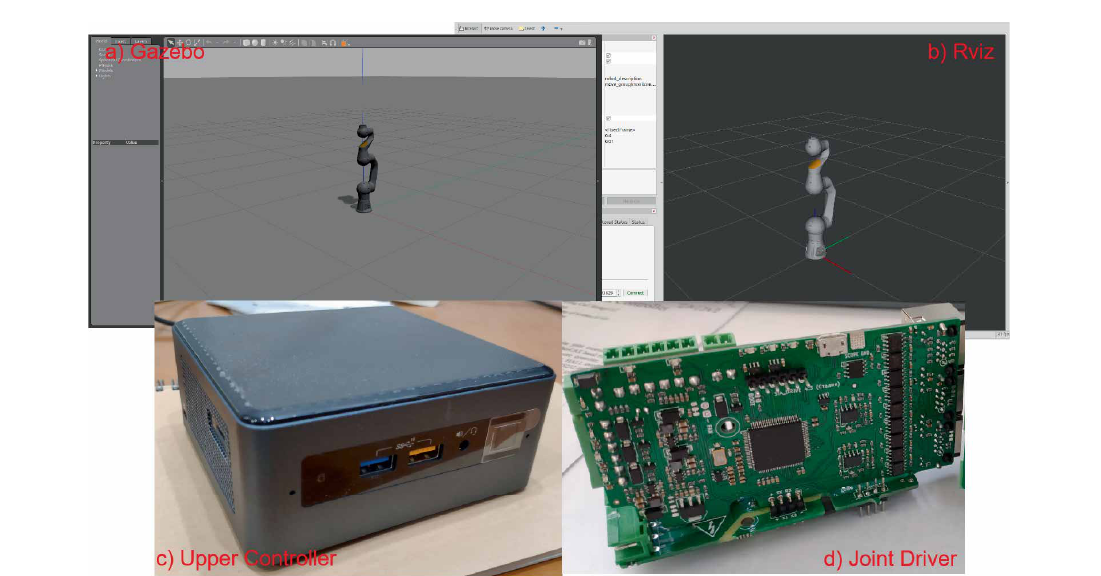
Figure 9: Experimental platform. (a) The Gazebo for simulation; (b) Rviz the UI sytem; (c) upper controller with Linux; (d) joint driver based on